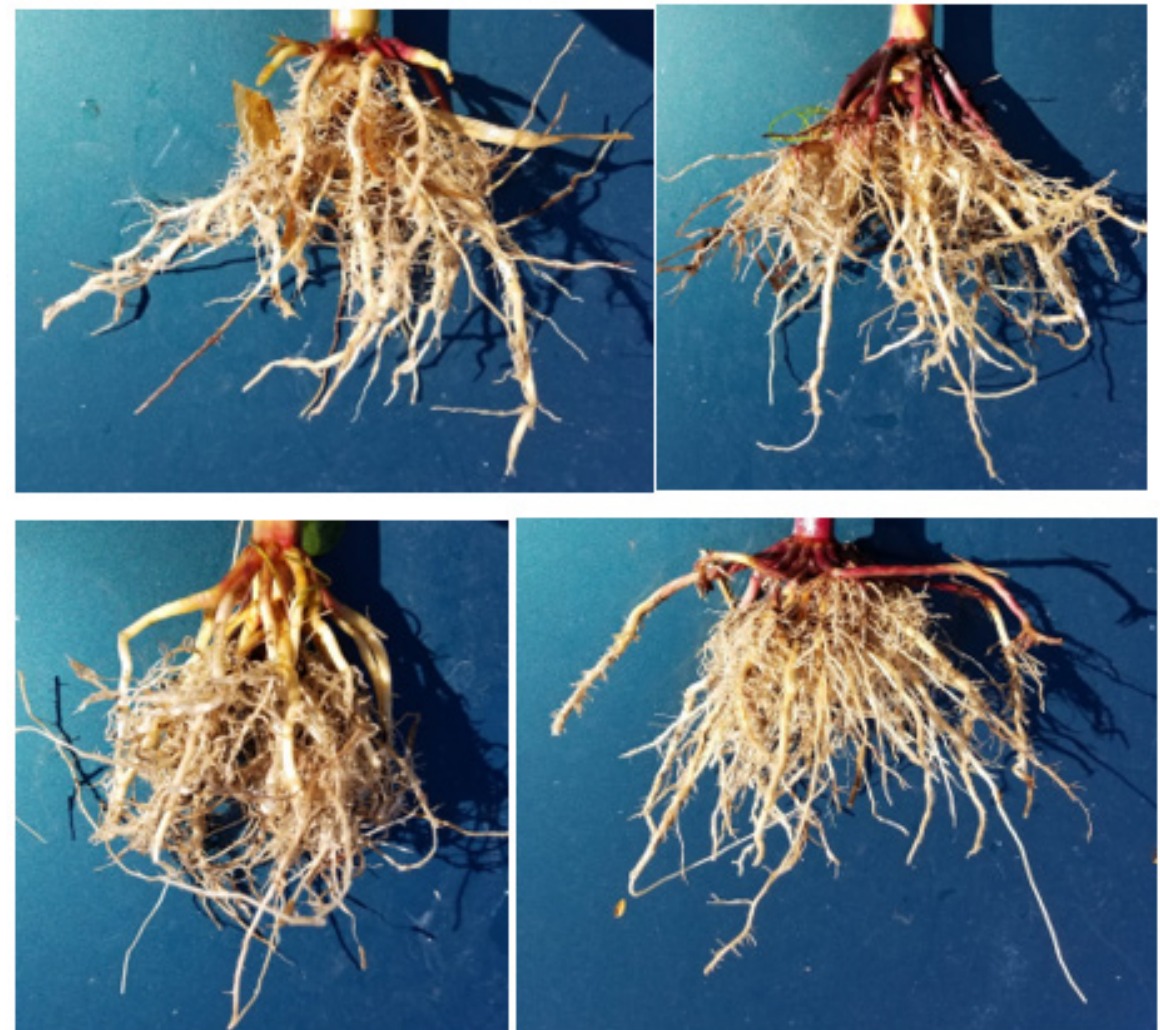
Figure 13: Root systems for Mandaamin Institute bred inbreds derived from different breeding families advanced on N limited sites in 2017 from the JR field (picture on bottom right) or from the Creek Field (other pictures). Picture in top left is from family C4-6; picture in top right is from family LAT7; picture in bottom left is from family NG10-2-3-2; picture in bottom right is from family